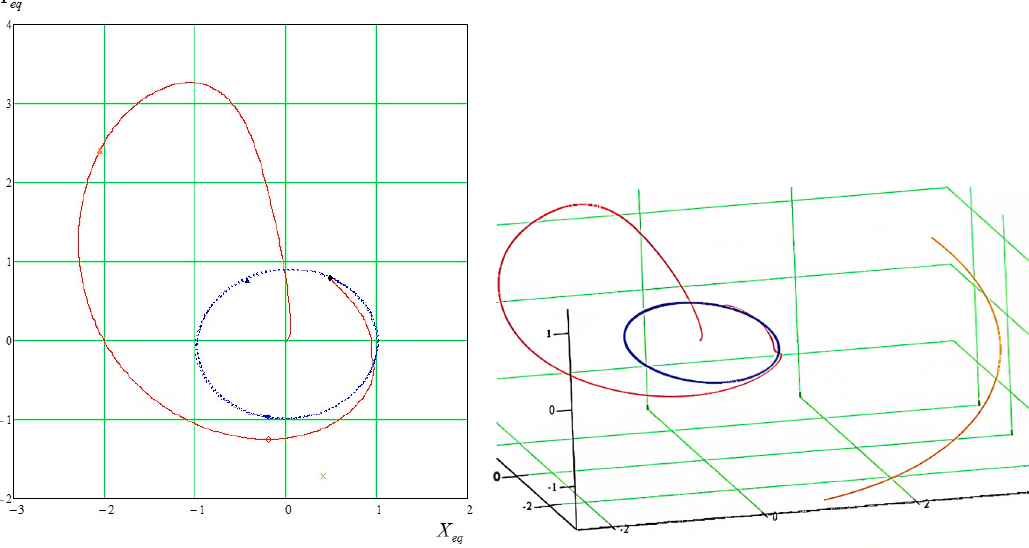
Figure 30. Section of the spacecraft’s selenocentric motion ending with the moment of entering the terminal orbit. The blue cross shows the point of application of the braking impulse. A fragment of the trajectory is shown in the selenocentric coordinate system with fixed axes oriented along the axes of the system ξ C η ( ζ ) ( ξ M C η M ( ζ )).